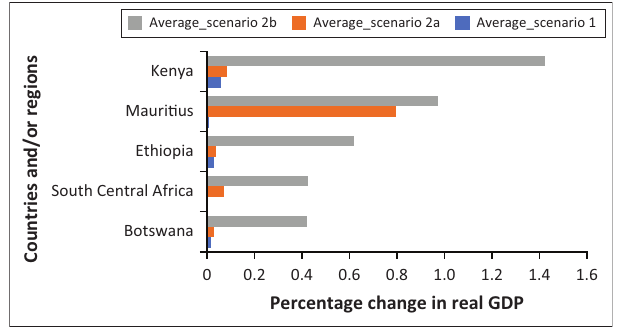
FIGURE 2: Projected cumulative average percentage changes in real GDP in the top five performing countries/regions: 2019‒2024 (ranked according to Scenario 2b results).